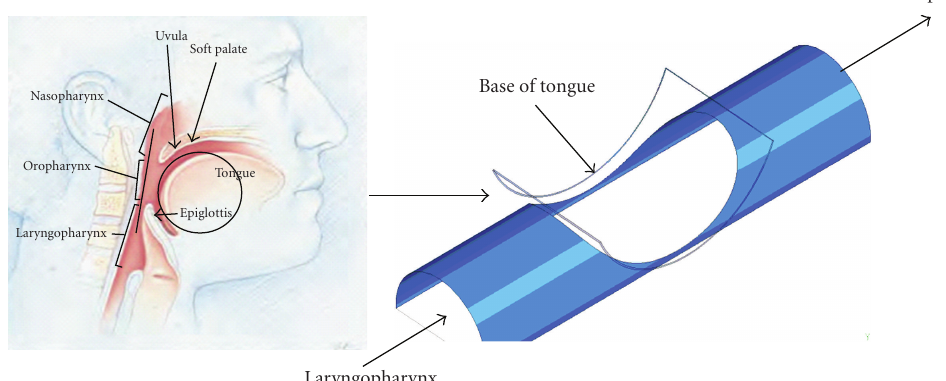
Figure 1: Pharyngeal airway